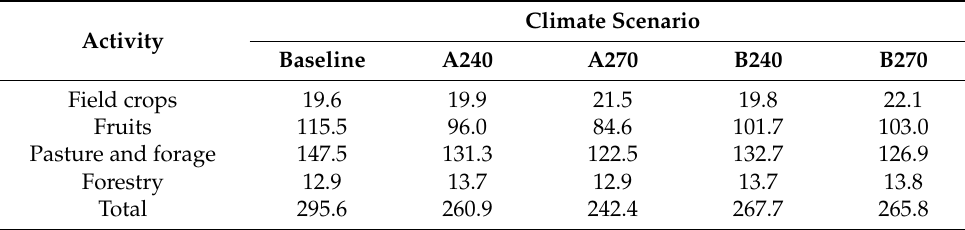
Table 3. Number of employee-years by activity under different climate-change scenarios (thousands of